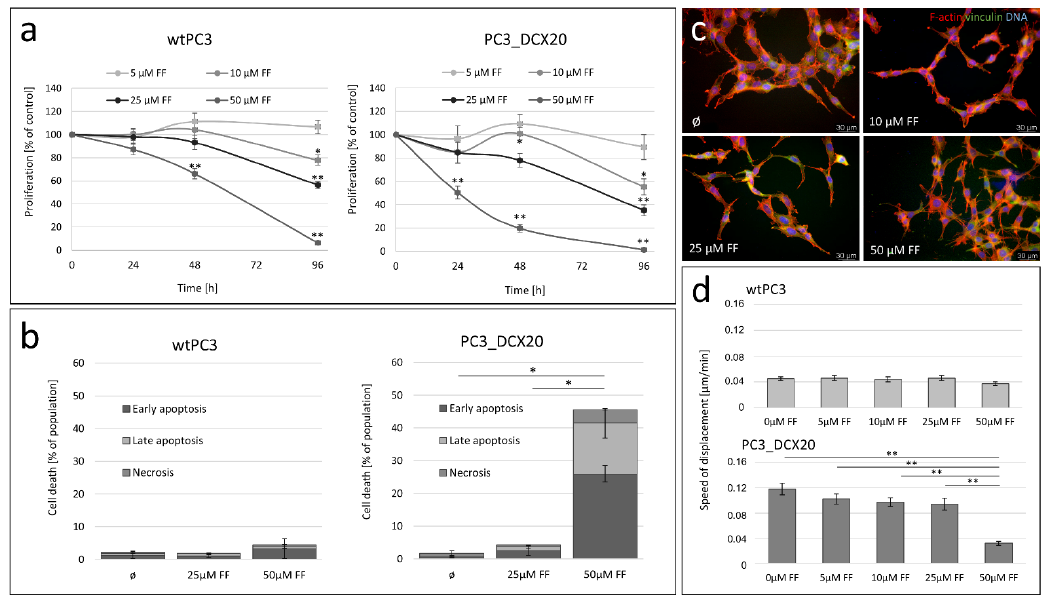
Figure 2. FF sensitivity of PC3_DCX20 cells. ( a ) Proliferation of wtPC3 and PC3_DCX20 cells in the presence of FF (5–50 μ M) estimated with the Coulter counter at the indicated time-points. ( b ) wtPC3